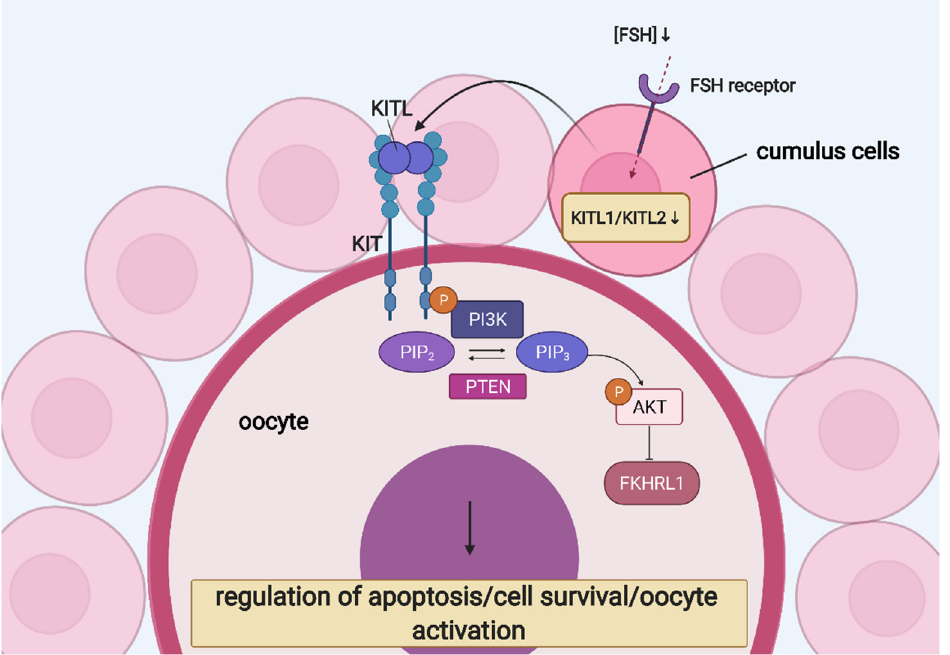
Figure 4. KIT signalling in CC–oocyte interaction: regulation of oocyte growth and development.